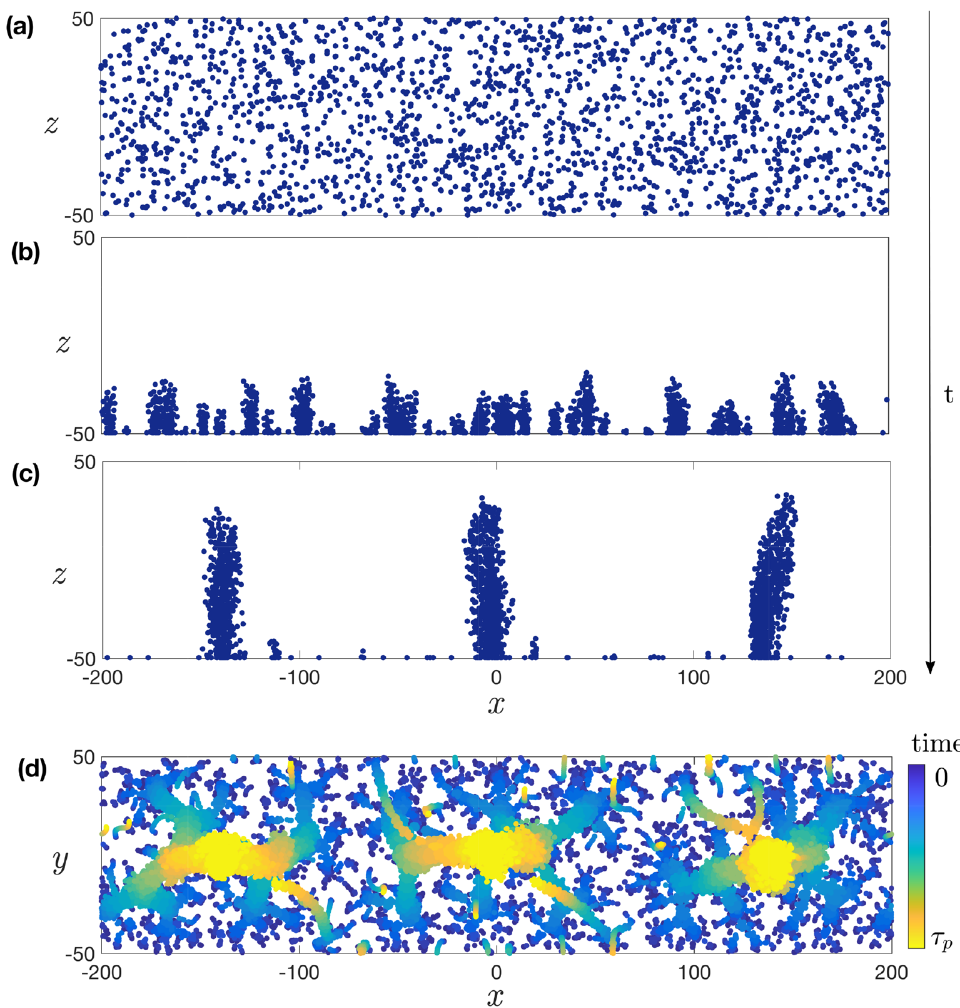
Figure 4. ( a ) Growth of plumes in the model starting from randomly distributed bacteria. ( b ) Swimmers accumulate at the wall and cluster due to hydrodynamic interactions. ( c ) The flows induced by the swimmers are sufficiently strong to detach some bacteria from the wall, leading to elongated plumes. ( d ) x − y plane